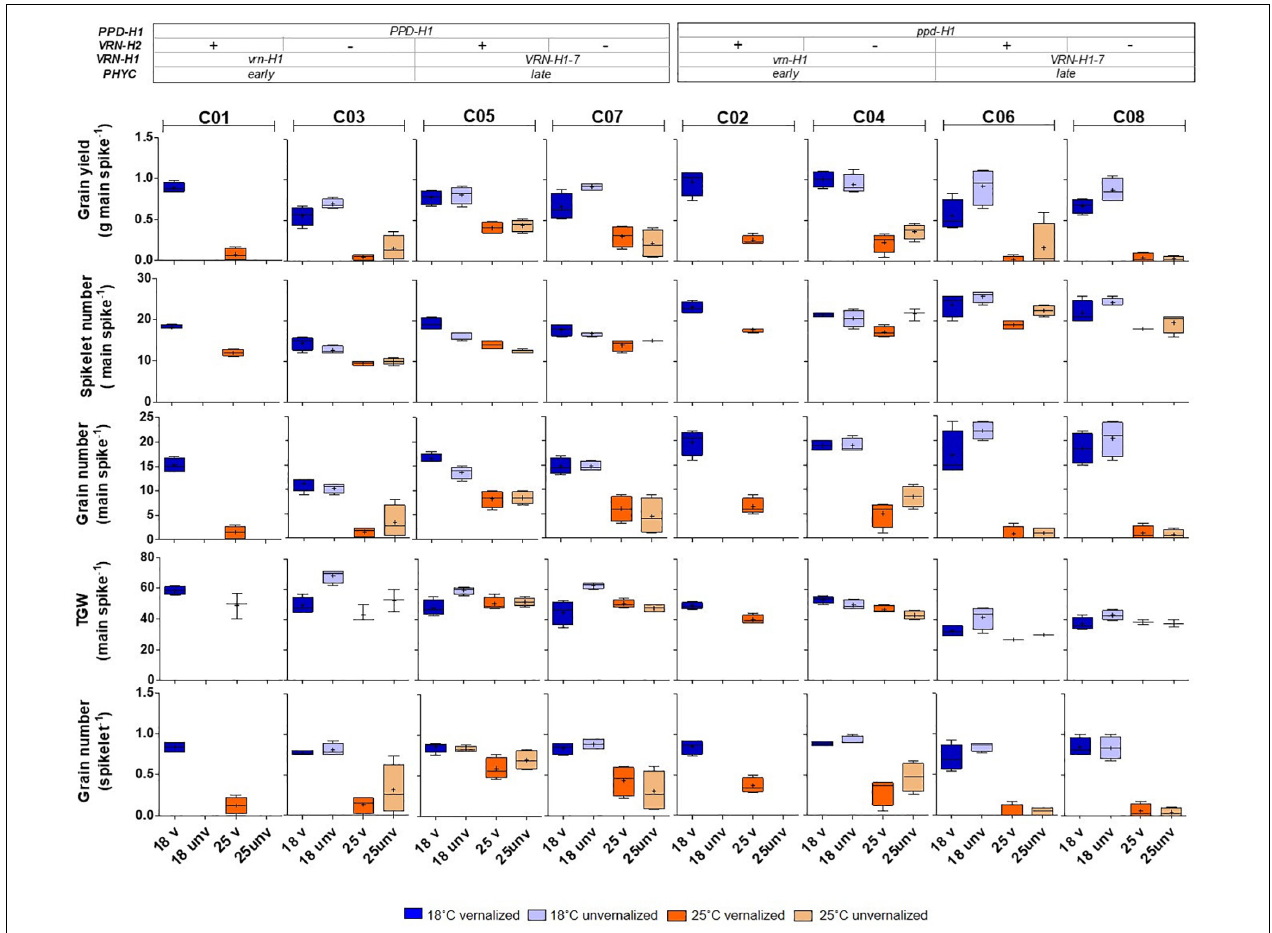
FIGURE 5 | Inflorescence traits corresponding to the main spike: grain yield, spikelet number, grain number, thousand grain weight (TGW), and grain number per spikelet of eight barley NILs subjected to non-vernalized and vernalized conditions and grown at 18 and 25 ◦ C. The genetic composition of the lines is described in the top